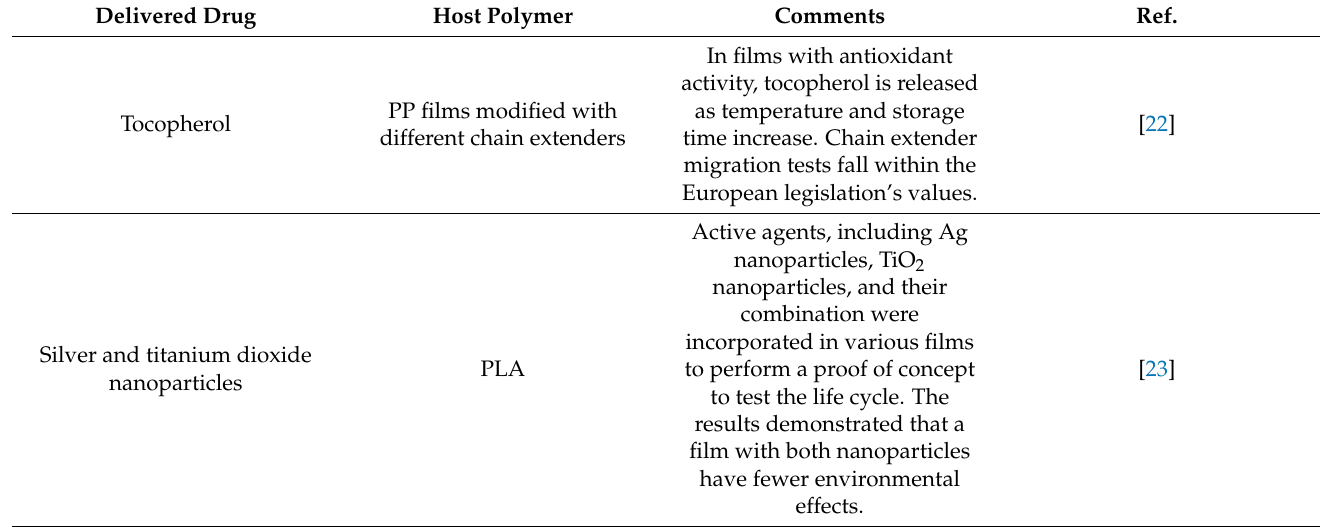
Table 1. Classification of the most relevant publications of the last ten years about active packaging through chemical species delivery, identifying the delivered drug, the host polymer, and some comments about the obtained